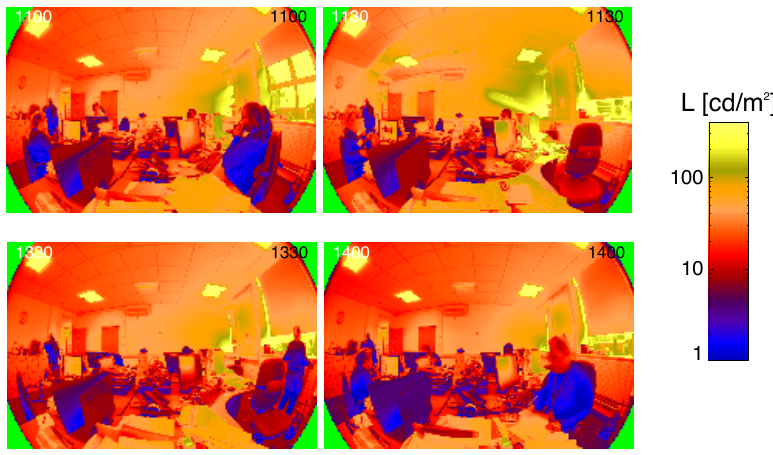
Figure 5. Selected false-colour luminance images from around the time of visual comfort actions (VCAs), morning (top two images) and afternoon (lower two images). Note, the scale of luminance (cd/m 2 ) and time stamps are in the corner of each